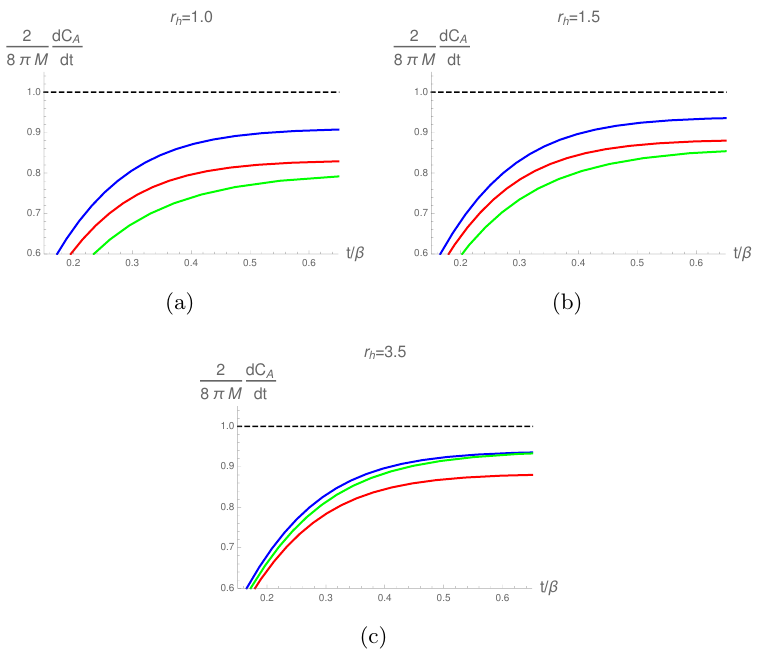
Figure 11 . dC V is plotted against t=(cid:12) for di(cid:11)erent values of the horizon radius r h . Here we have dt used d = 3 and n = 1, and as before, the blue curves indicate a = 0 : 05, the red curves have a = 0 : 1 and the green curves a = 0 :